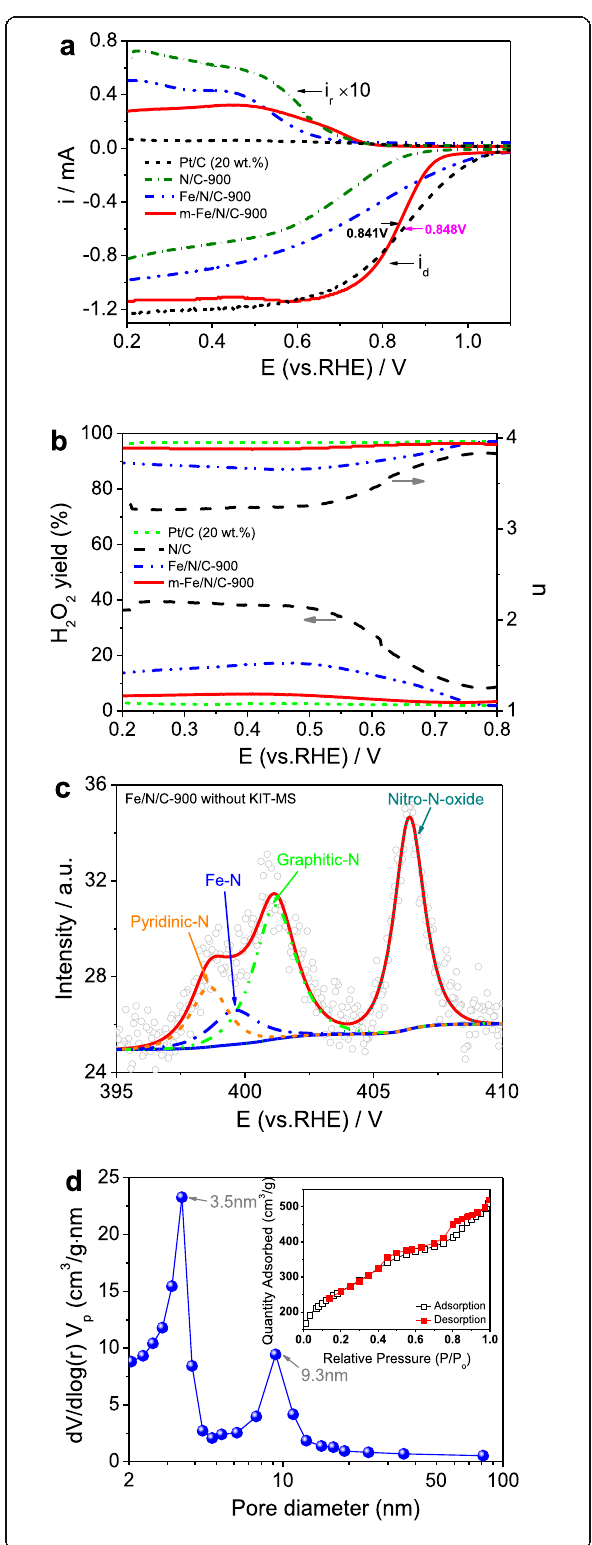
Fig. 10 a Disk and ring currents obtained with LSVs on RRDE for N/ C-900, Fe/N/C-900, m -Fe/N/C-900, and Pt/C (20 wt.%) in O 2 -saturated 0.1 mol l -1 KOH solution. b The corresponding electron